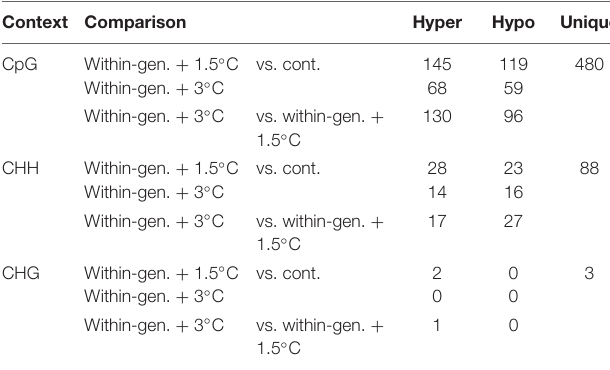
Hyper and hypo indicate higher and lower methylation in the left treatment compared to the right treatment in the comparison column, respectively. The unique number of DMRs in each methylation context are shown on the last